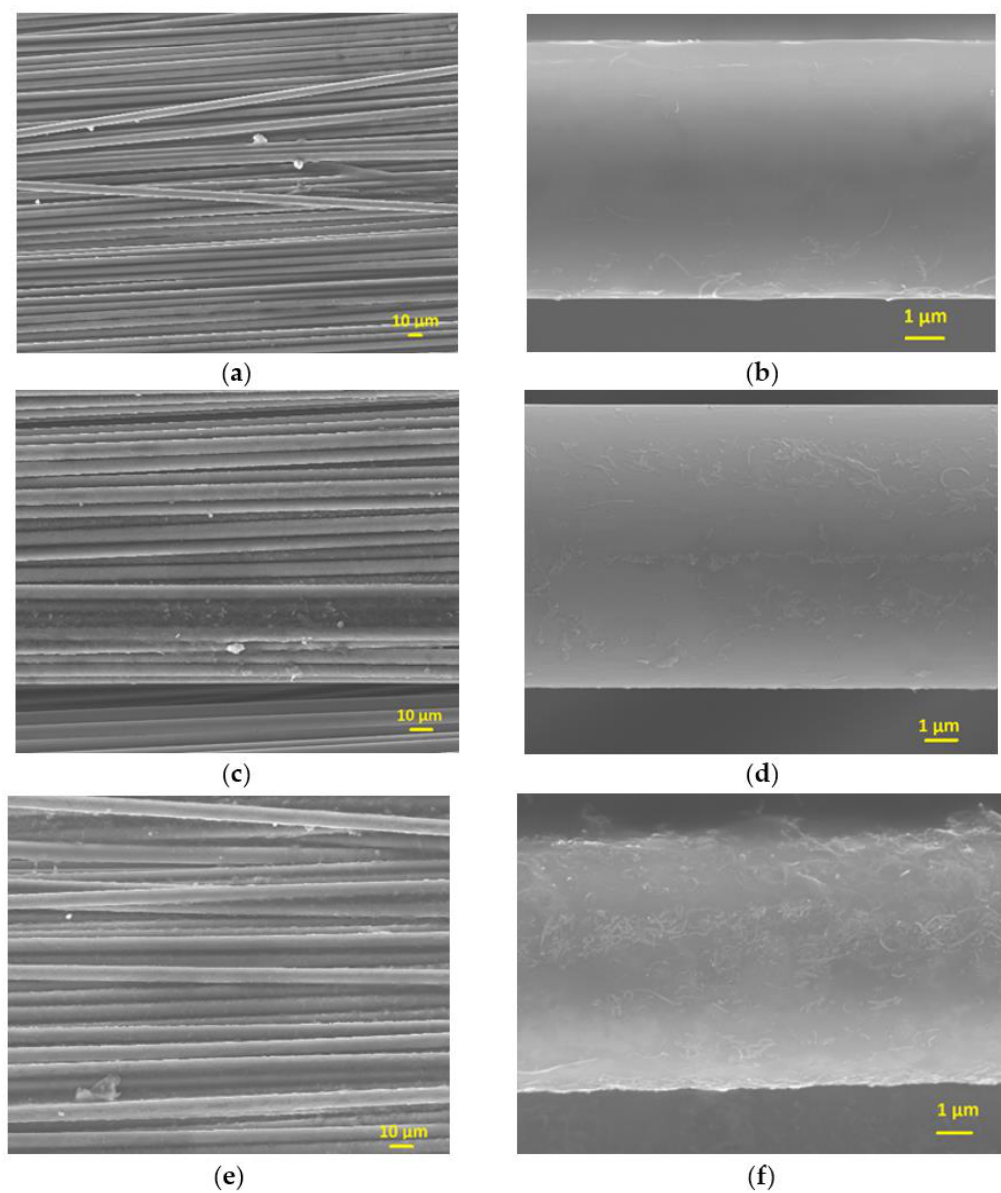
Figure 4. T700 CFs with CNFs in sizing agent ( a , b ) 1% CNFs, ( c , d ) 5% CNFs ( e , f ) 10% CNFs.